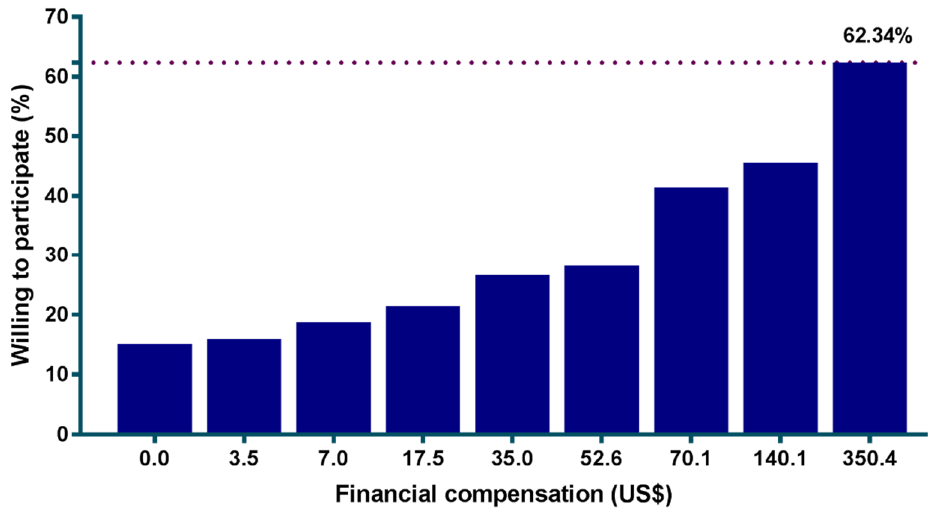
Figure 1. Relationship between financial compensation and the proportion of participants who are willing to participate in a Zika vaccine trial in Aceh and West Sumatra, Indonesia. Purple dotted line indicates the maximum percentage of participants who are willing to participate at the highest financial compensation.